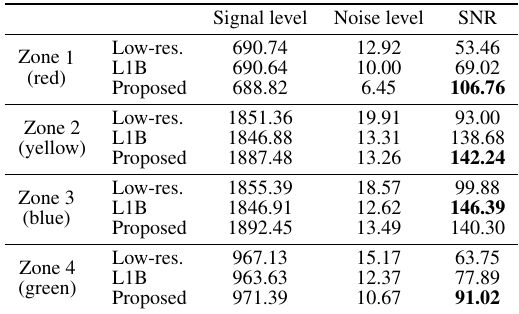
Table 1. Signal-to-noise ratio (SNR) estimated on the SkySat images of Figure 8 before and after super-resolution for two methods (L1B provided by Planet and our ACT-spline). Super-resolution always improves the SNR and ACT-spline performs almost always the best for all signal levels.